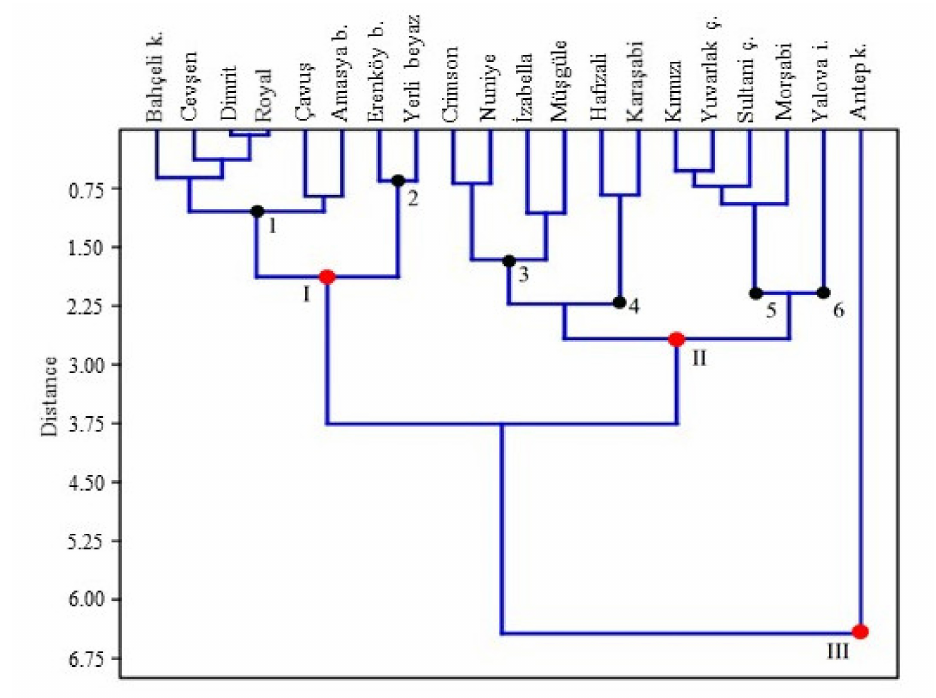
Figure 7. Dendrogram of 20 grape cultivars for the first two principal component scores using hierarchical cluster analysis (between-group linkage method and Euclidean